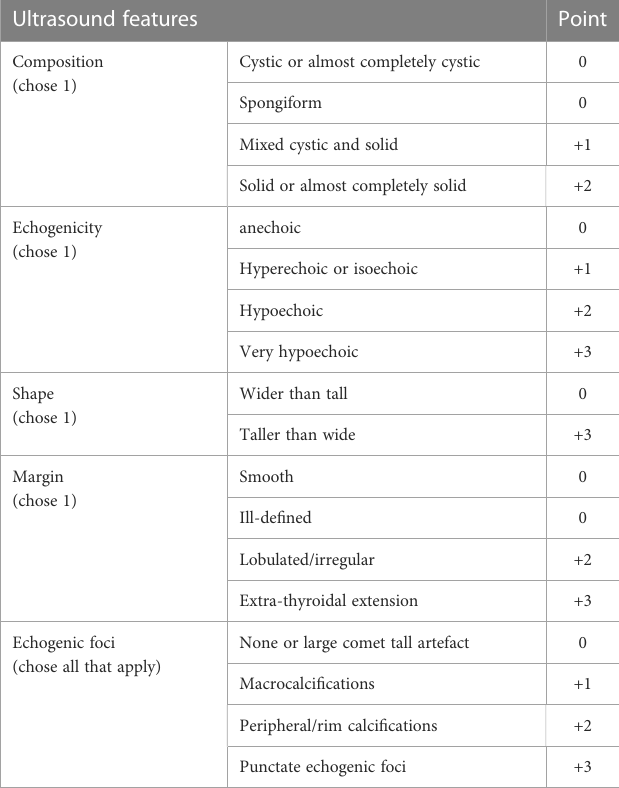
TABLE 1 Thyroid Imaging Reporting and Data System of American College of Radiology